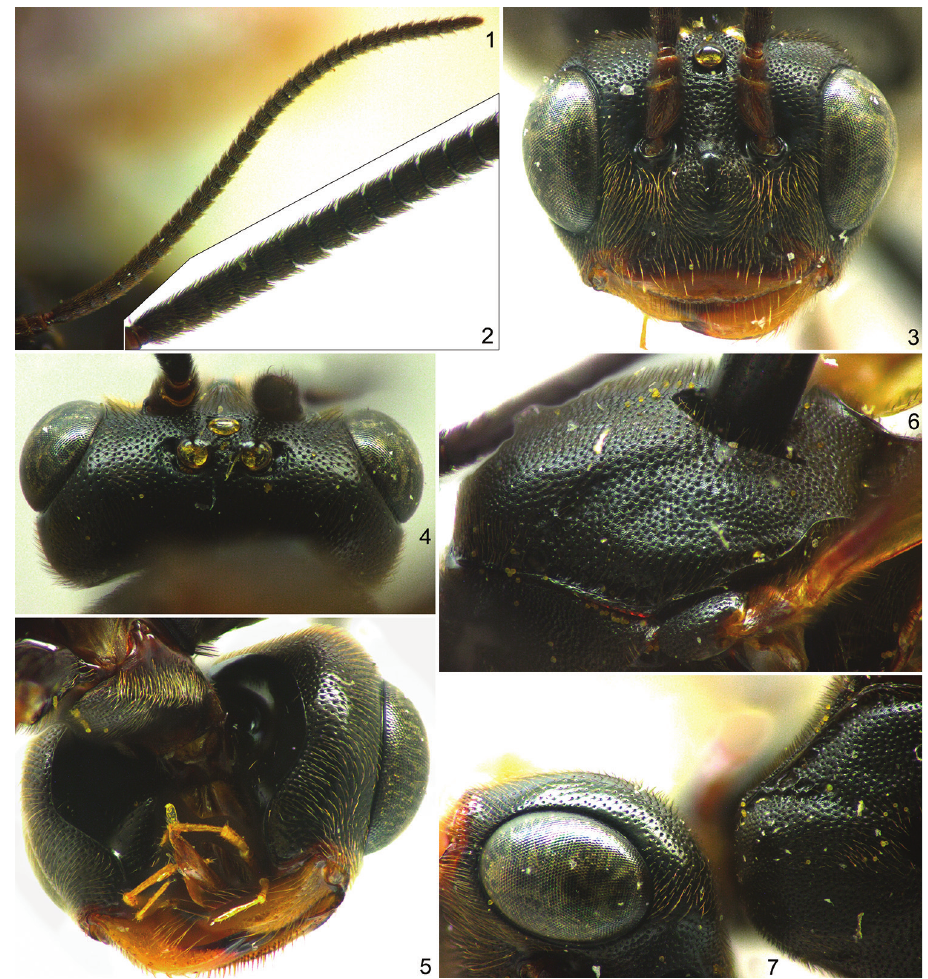
Figures 1–7. Stethantyx durrelli sp. n., female, holotype: 1 antenna, lateral view 2 base of antenna, lateral view 3 head, frontal view 4 head, dorsal view 5 head, ventro-postero-lateral view 6 mesoscutum, dorsolateral view 7 head and scutellum, dorsolateral